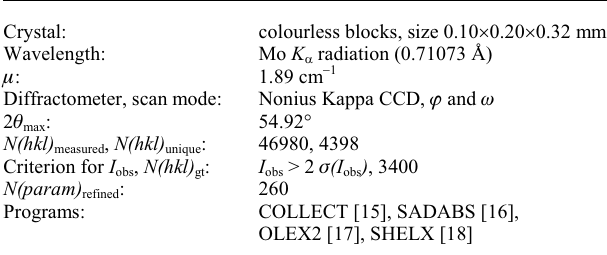
Table 1. Data collection and handling.